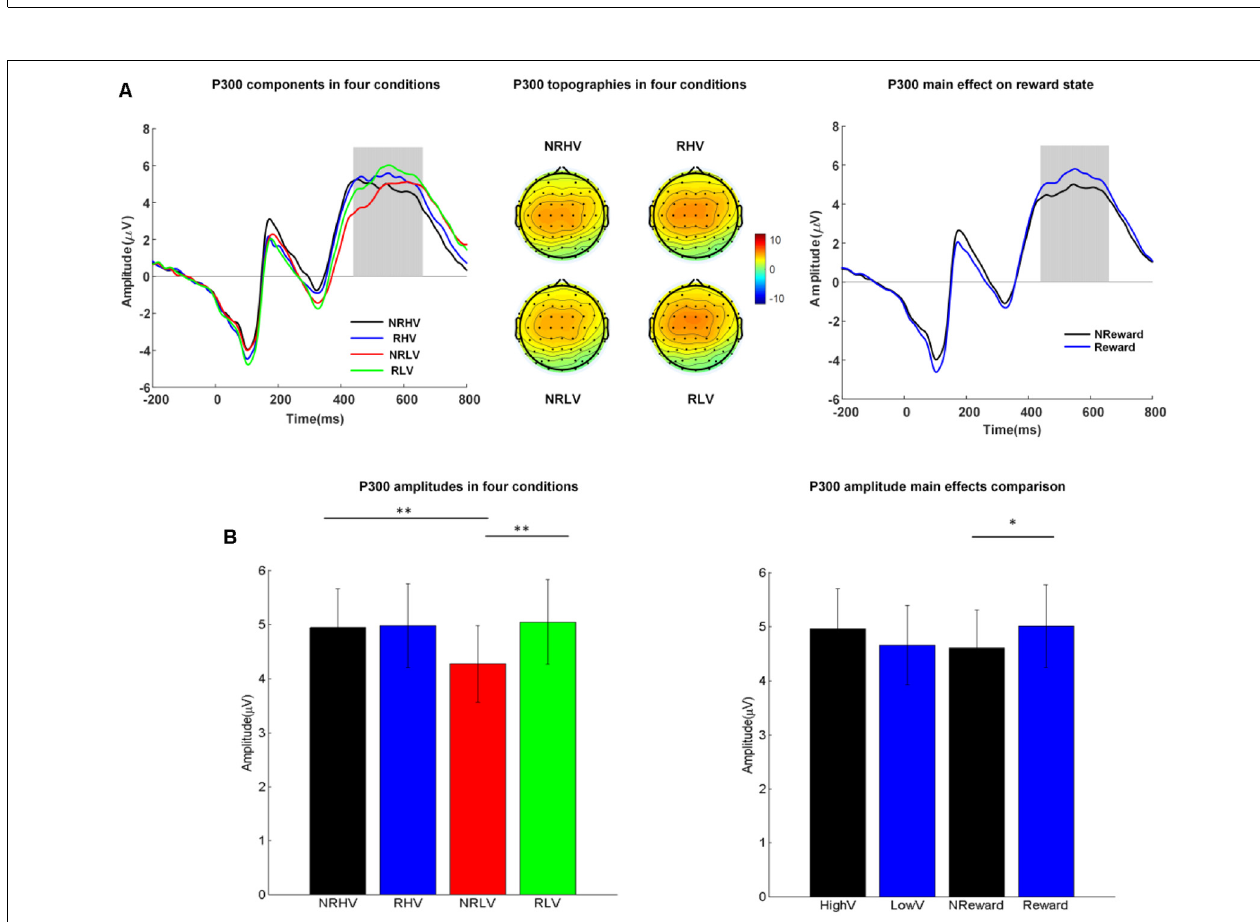
in the low vigilance state than in the high vigilance state in the no-reward condition (NRLV: mean = 0.88, SD = 0.12, NRHV: mean = 0.93, SD = 0.06, F (1,19) = 5.24, p = 0.03, η 2